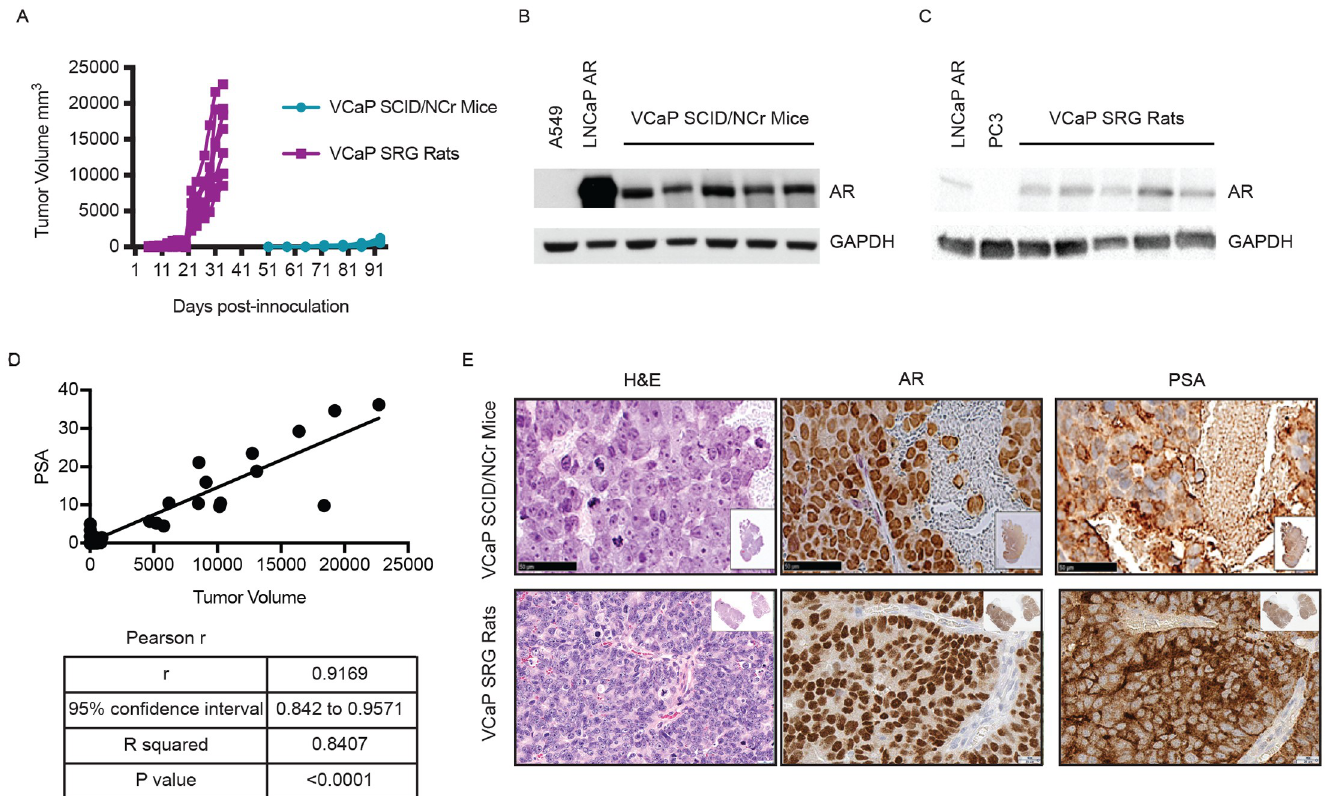
Fig 4. VCaP xenograft model in SCID/NCr mouse and SRG rat. SCID/NCr mice and SRG rats were inoculated with 5x10 6 and 10x10 6 VCaP cells, respectively, subcutaneously in the hind flank. Tumor width and length were measured three times weekly to calculate volume. A) Tumor kinetics in the SRG rat vs. SCID/NCr mouse. Each line represents tumor growth in an individual SRG rat or SCID/NCr mouse. B) Western blotting for AR in tumor tissue from the SCID/NCr mice. C) Western blotting for AR in tumor tissue from the SRG rat. D) Compilation of PSA in the serum of SRG rat inoculated with VCaP cells correlates with tumor volume. E) H&E staining and IHC staining for AR and PSA in VCaP tumor tissue from SCID/NCr mice and SRG rat.